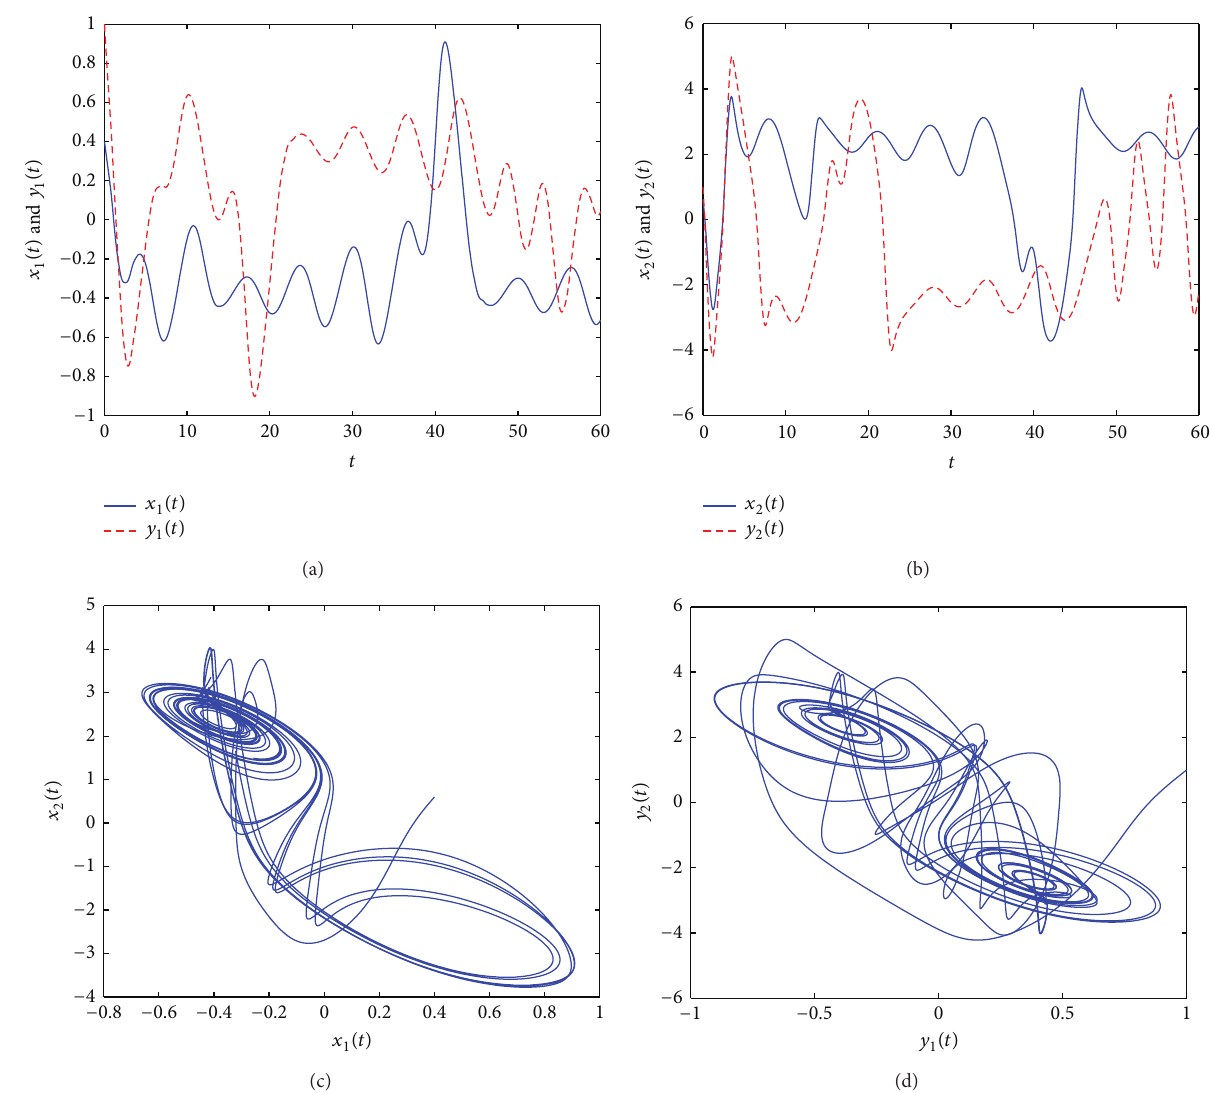
Figure 1: Time response of state variables and the phase plots of the drive system and response system in Example 12 without impulsive